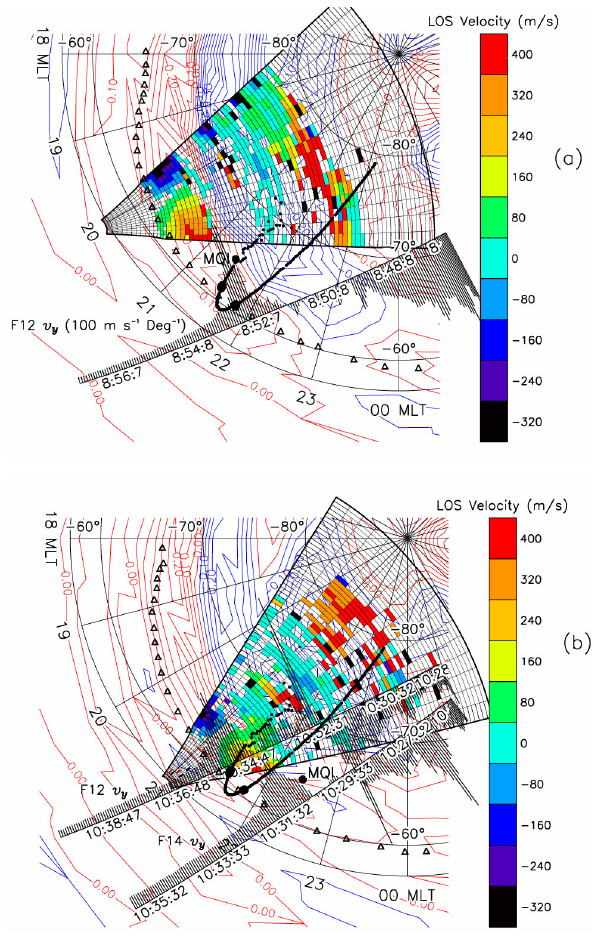
44 Fig. 8. (a) TIGER radar observations of LOS Doppler velocity mea-